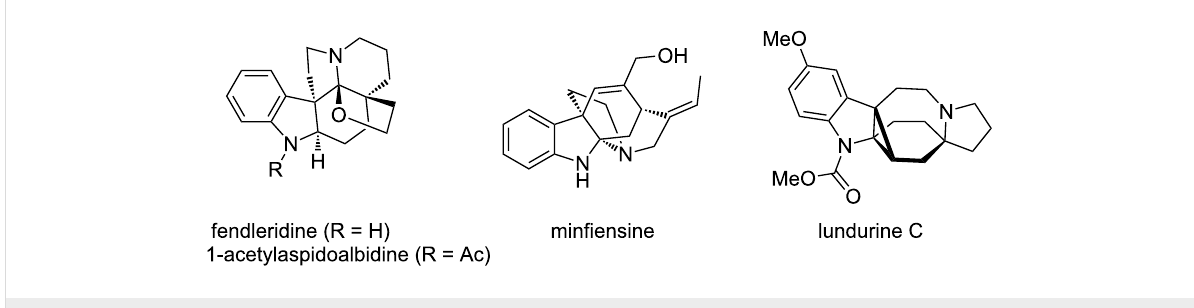
Figure 2: Alkaloids containing indole-based propellanes.